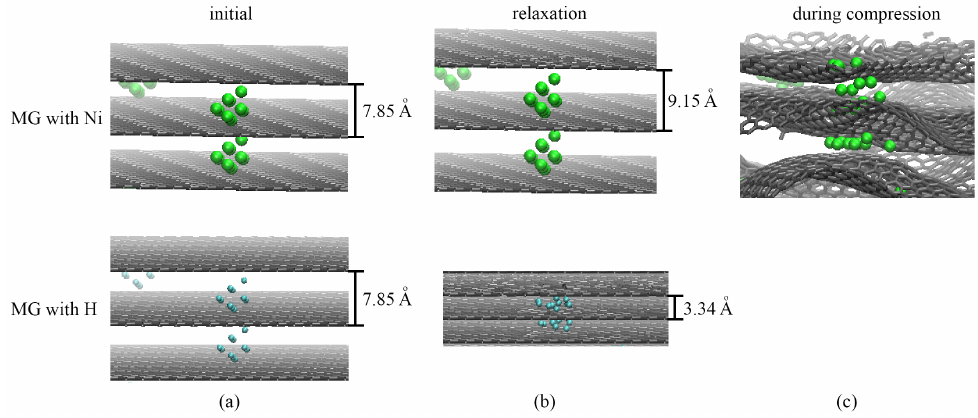
Figure 2. Snapshots of the part of the simulation cell of MG with Ni and H nanoclusters at ( a ) the initial state, ( b ) after relaxation and ( c ) during compression. Nickel atoms are shown in green, H atoms are shown in blue, and the graphene layers are shown in